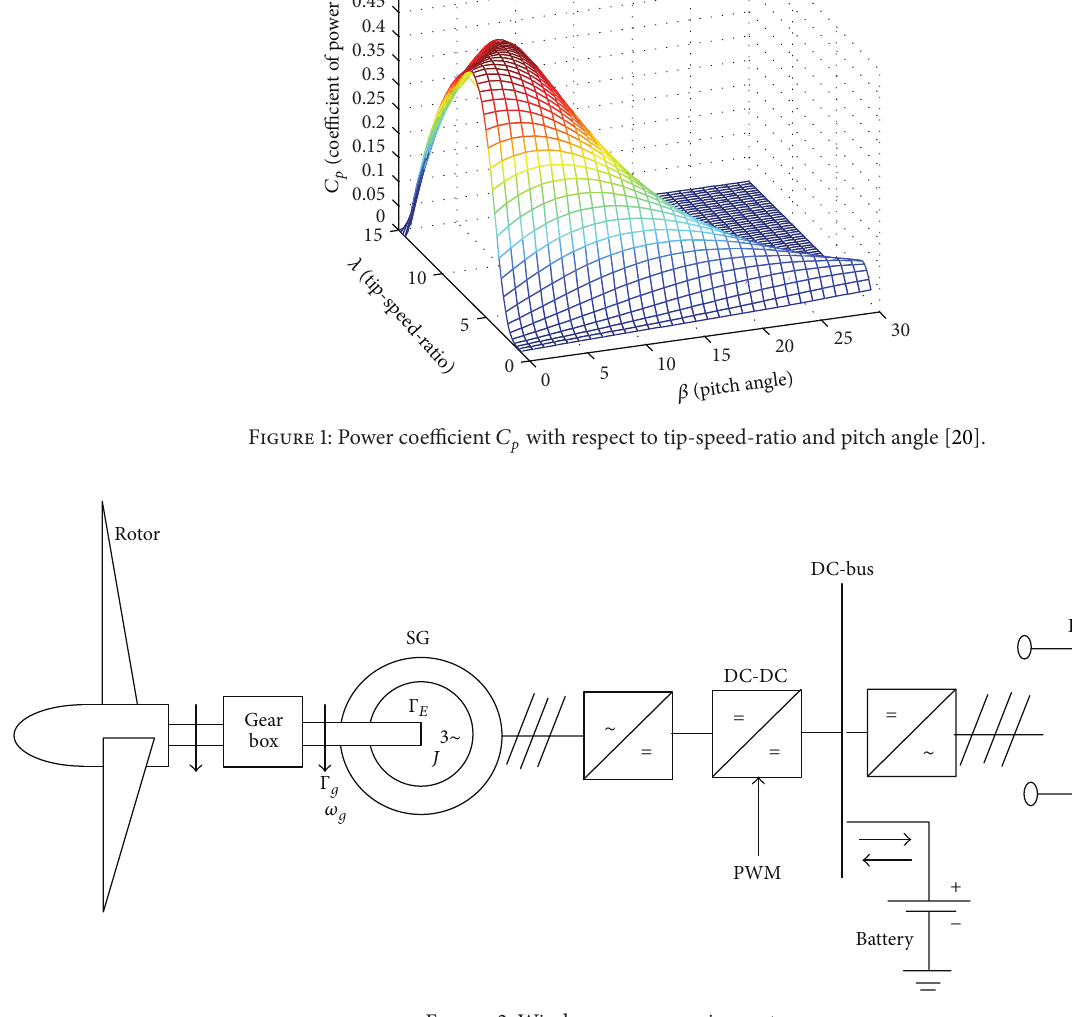
Figure 2: Wind energy conversion